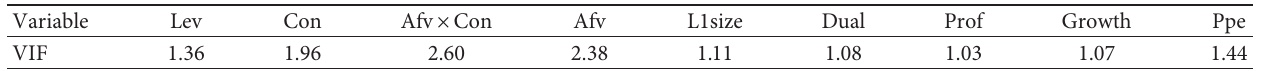
Table 3: Variance inflation factor (VIF) test.